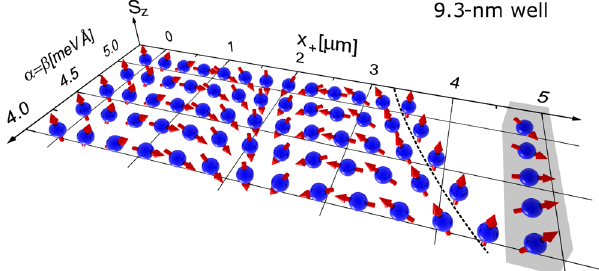
FIG. 1. Stretchable PSHs. Illustration of spin helices at different values of α ¼ β accessible in the measurements. The position x þ for one 2 π rotation (dashed curve) is changing for the gate-locked regime α ¼ β . The gray box highlights how the spin rotation can be controlled( insitu )atfixedposition ∼ 4 . 8 μ m by ∼ π = 2 overthesame ¯110 (cid:2) rangeof α ¼ β .The ˆ x þ ∥ ½ 110 (cid:2) and ˆ x − ∥ ½